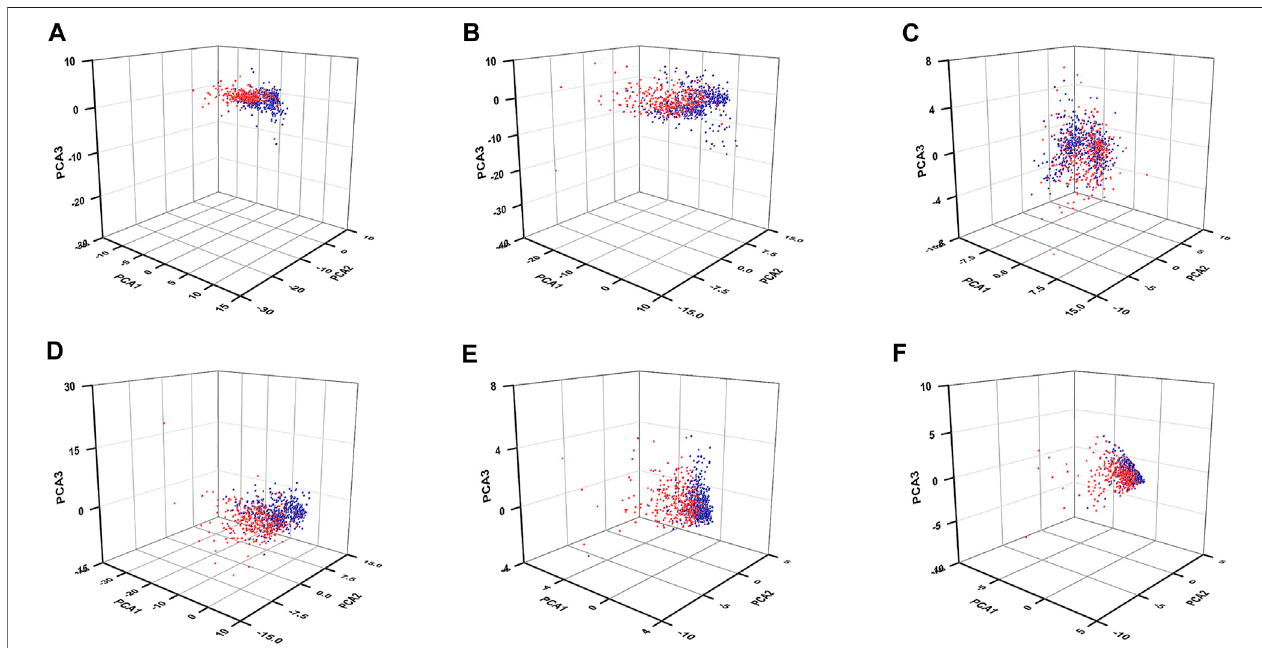
FIGURE 4 | PCA for renal cancer patients with different risk values. PCA plots display the distribution ofpatients with renal cancer with high-risk value and low-risk valuebasedon61FR-DEGs (A) ,176DELs (B) ,42FR-DEGs (C) ,129FR-DELs (D) ,7FR-DELs (E) ,and5FR-DELs (F) .Bluemeanslowrisk.Readmeanshighrisk.PCA, principal component analysis; FR-DEGs, ferroptosis-related differentially expressed genes; DELs, differentially expressed lncRNAs; FR-DELs, ferroptosis-related differentially expressed